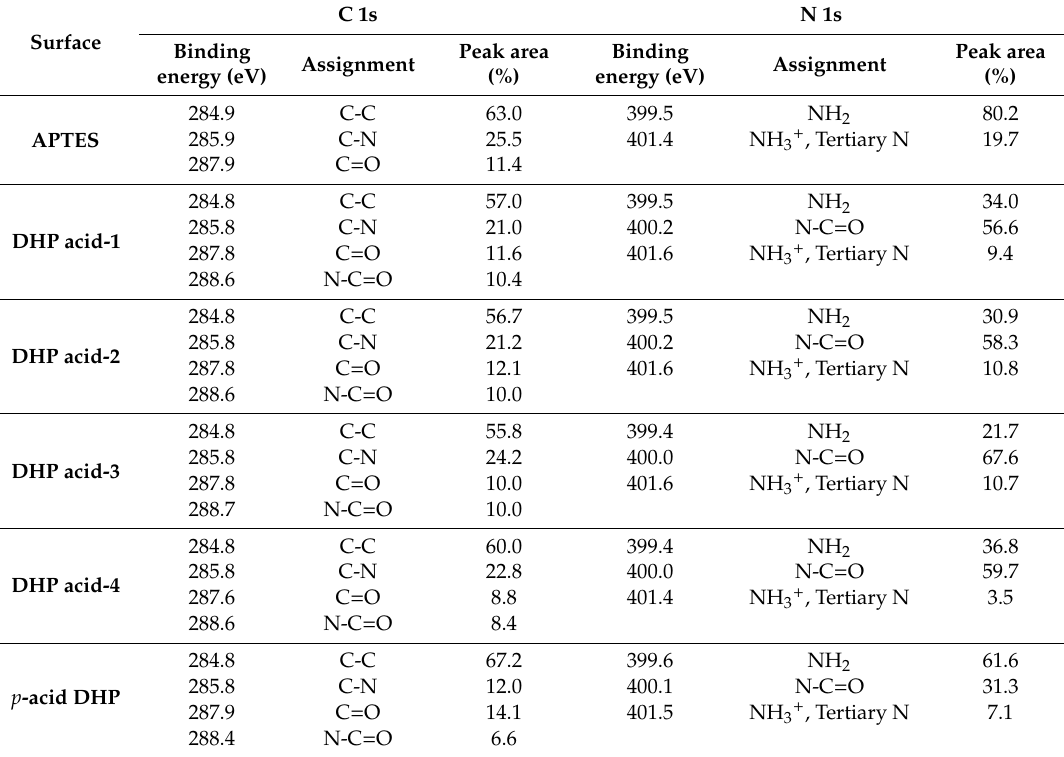
Table 2. XPS binding energies for C1s and N1s and proposed assignments with percentage peak intensities.